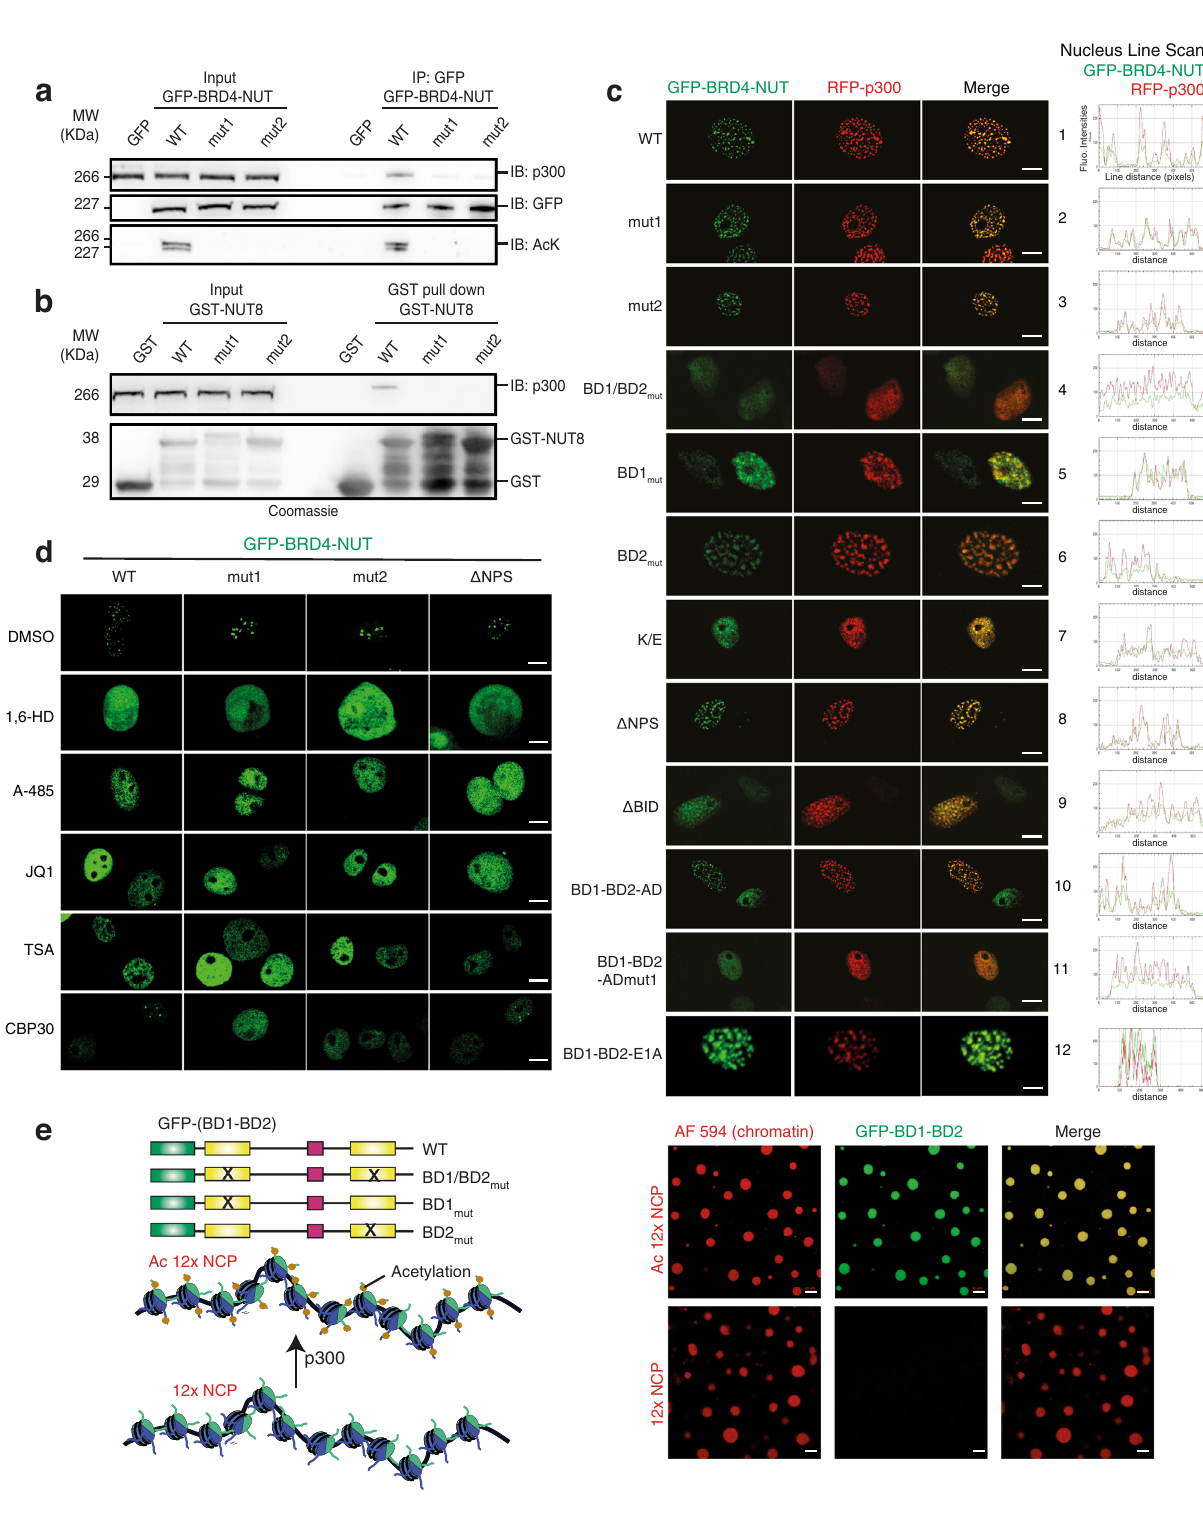
concentrations of NCPs were incubated with p300s or p300 core. Panels c-f: Top two images: Analysis by SDS – PAGE followed by Coomassie staining. Bottom two images: 14 C phosphor imaging. Experiments c-f wererepeated independently three timeswithconsistency.Representativedataareshown.Sourcedataareprovidedas aSourceData fi le. g Cos7cellsweretransfectedwiththeHA-taggedp300WT(top) or p300 Δ 1813-1838 (bottom) and analysed by anti HA immuno fl uorescence. Four representative nuclei are shown. The percentage of cells showing condensates ( n =100 cells) is indicated. Experiments were repeated twice with consistency. Scale bars, 5 μ